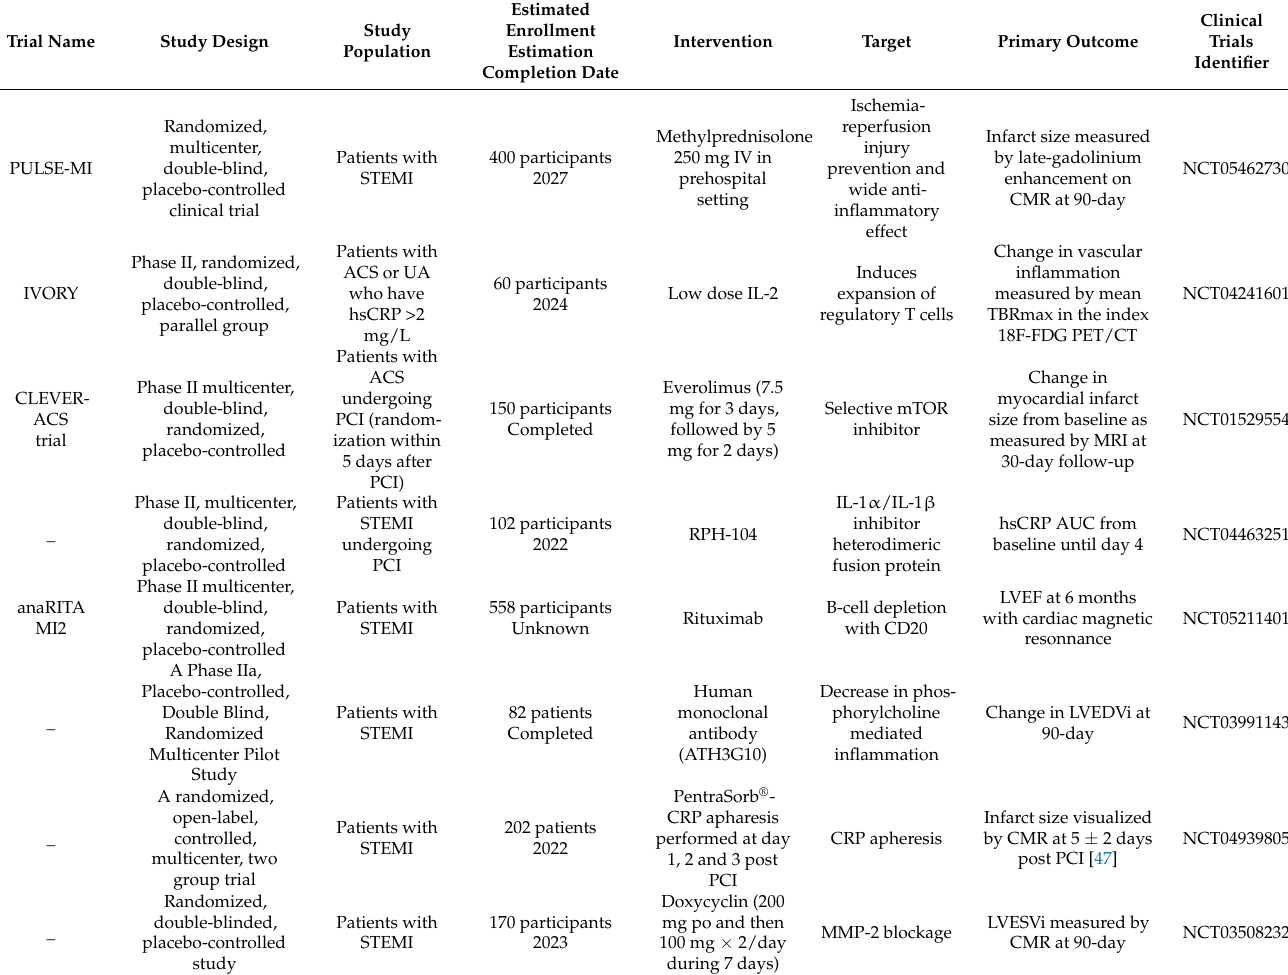
Table 2. Ongoing clinical studies of treatments targeting inflammation in post-myocardial